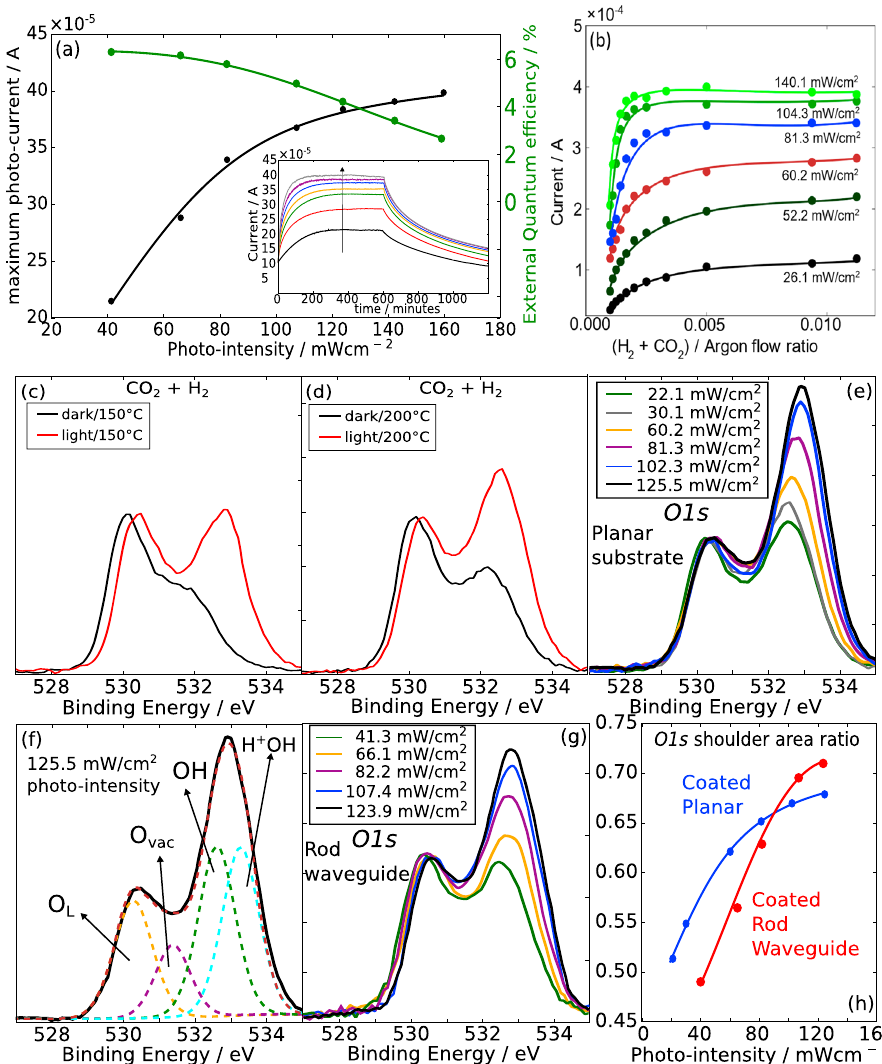
Fig. 2 Relating photo-charge and surface reactivity with photo-intensities. The photo-current trend with increasing photo-intensities; photocurrent changes with increasing fl ow concentration of 1 sccm of H 2 and 1 sccm of CO 2 in argon; glovebox protected XPS measurements of In 2 O 3 − x (OH) y nanorods coated on planar and cylindrical rod geometries after reactions in dark and photo-illuminated conditions at 1:1 H 2 :CO 2 pressure ratio atmosphere at various temperatures. a The photocurrent trend of the coated planar substrate under increasing photo-intensities shows a sharp rise at low photo-intensities below 100 mW/cm 2 and semi-saturation at higher photo-intensities. b Photocurrent increase with increasing H 2 + CO 2 gas concentrations and with increasing photo-intensities. c , d The O1s spectra of In 2 O 3 − x (OH) y nanorods on a planar surface at 150 °C and 200 °C post dark and photo-illumination of one hour in H 2 + CO 2 atmosphere (inset). The O1s spectrum of In 2 O 3 − x (OH) y nanorods as prepared on a planar surface, after an hour in a vacuum. The species with FWHM widths of less than 1.3 eV are oxide lattice, oxygen vacancy, and OH groups. e O1s spectra under H 2 + CO 2 at 200 °C under increasing photo- intensities of 1 h. The OH shoulder increases signi fi cantly with increasing photo-intensities. f The oxide species of lattice oxide, oxygen vacancies, OH, and H + OH species are seen for the sample under the highest photo-intensity of 125.5 mW/cm 2 . g The O1s spectra of the In 2 O 3 − x (OH) y nanorods coated on a rod waveguide after photo-illumination at 200 °C for 1 h, under increasing photo-intensities. h The O1s shoulder ratio of the In 2 O 3 − x (OH) y rods on planar substrates and rod waveguides as a function of increasing